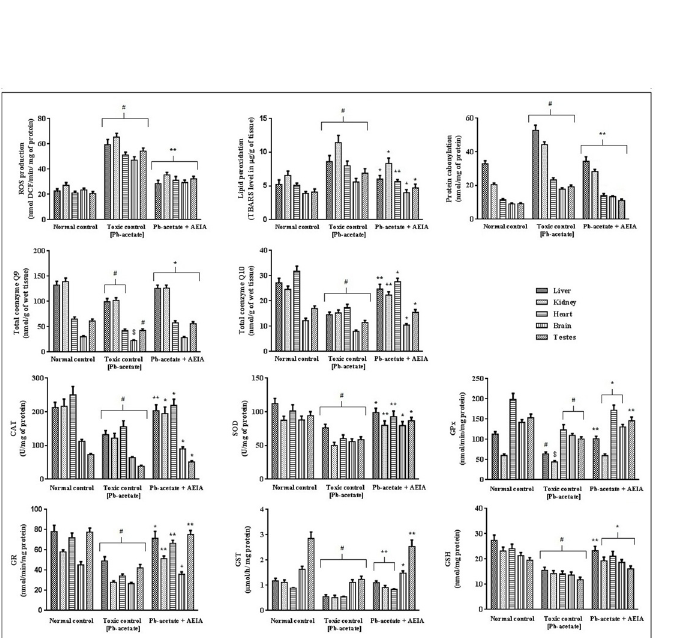
Fig 6. Effect on ROS production, lipid peroxidation, protein carbonylation, co-enzyme Q9, co-enzyme Q10, CAT, SOD, GPx, GR, GST and GSH in the absence (Pb-acetate) and existence of AEIA (Pb- acetate +AEIA) in experimental mice. Values are denoted as mean ± SE (n = 6). $ Values significantly differed (p < 0.05) from differed Pb-acetate control. # Values significantly differed (p < 0.01) from normal control. * Values significantly differed (p < 0.05) from differed Pb-acetate control. ** Values significantly differed (p < 0.01) from differed Pb-acetate control. SOD unit, “ U ” is defined as μ -moles inhibition of NBT- reduction/min while CAT unit “ U ” is defined as H 2 O 2